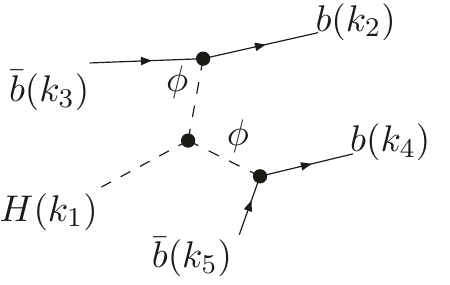
Figure 19 . Feynman diagram at leading order for exotic decay of the Higgs boson to four bottom quarks via two light